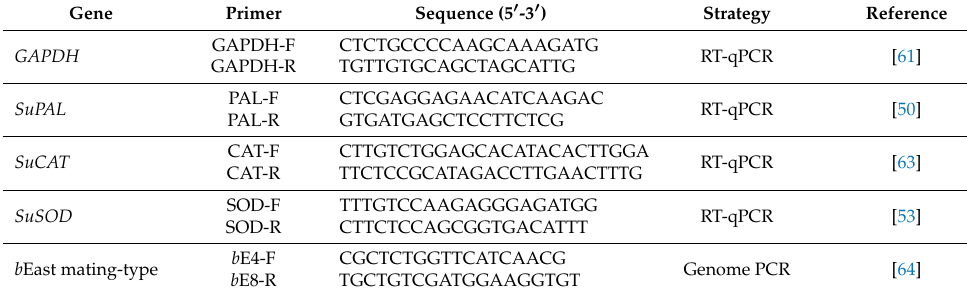
Table 3. Primers used in this